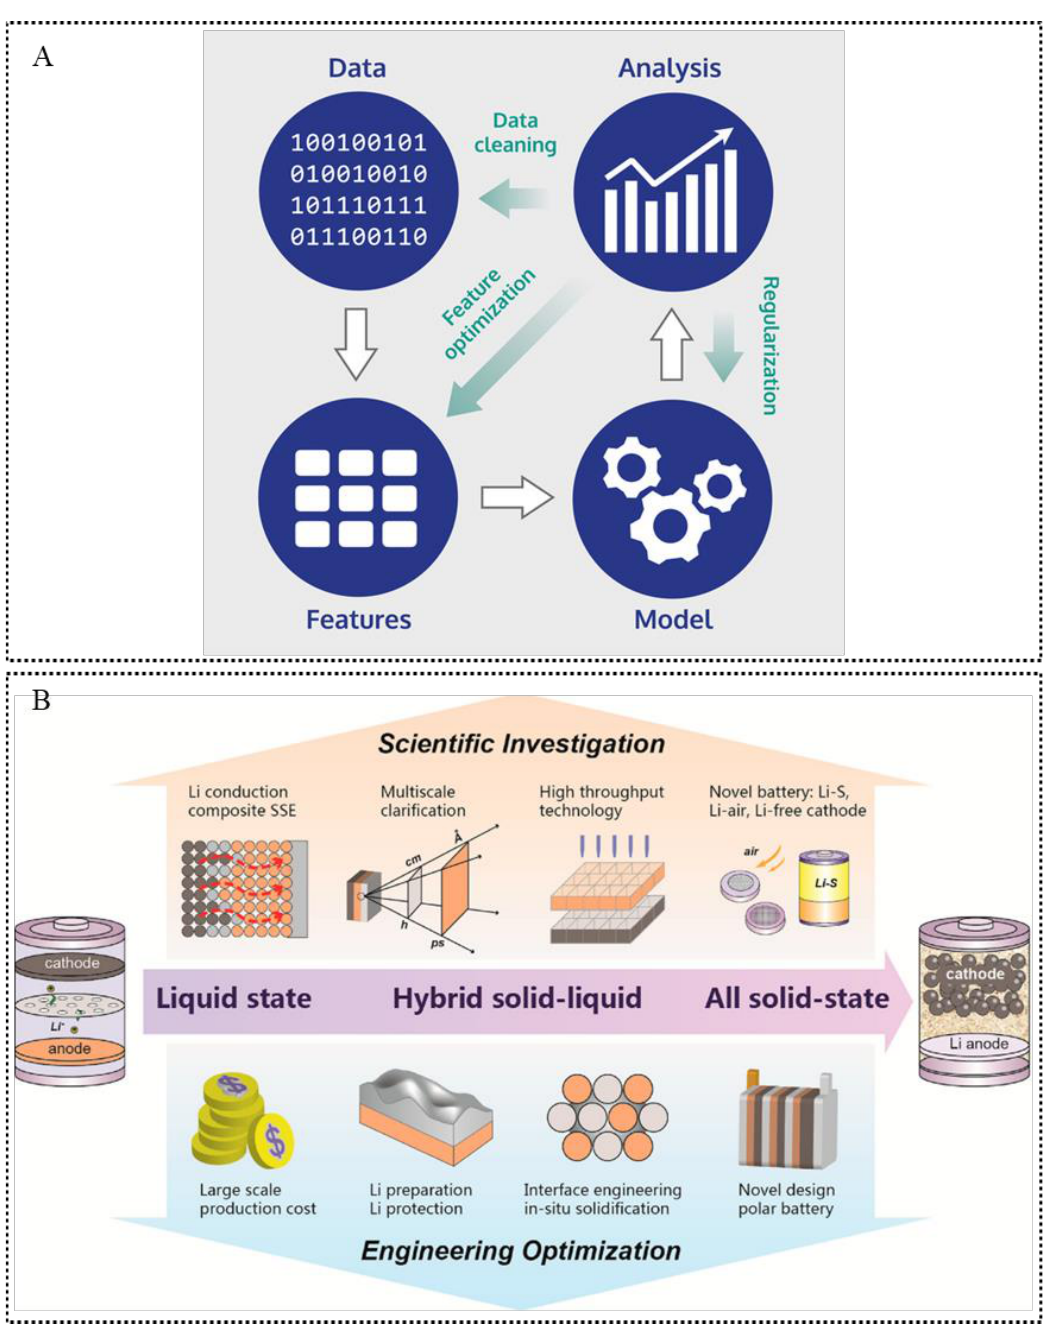
Figure 1. ( A ) Key steps in building a ML model. The white arrows indicate the data flow; green arrows indicate actions that can be identified and performed after analysis to improve the model’s performance. Reprinted from Reference [9] with permission from John Wiley and Sons. ( B ) Perspec- tives for future studies on solid-state batteries. Reprinted from Reference [13] with permission from American Chemical Society.